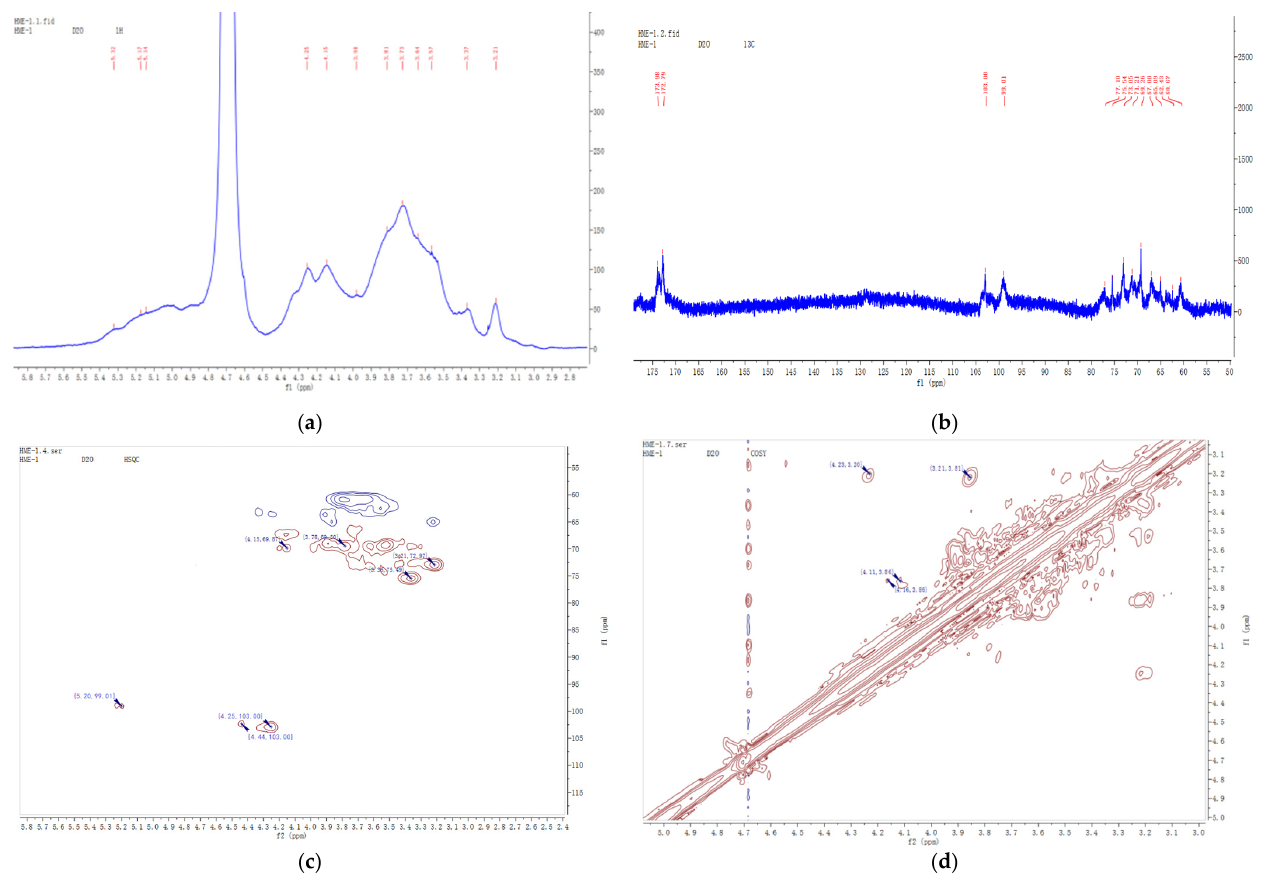
Figure 4. 1 H NMR ( a ), 13 C NMR ( b ), HSQC ( c ) and COSY ( d ) spectra of AAP-b2.